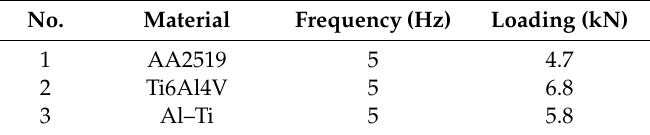
Table 2. Presentation of set parameters used in generation of a fatigue